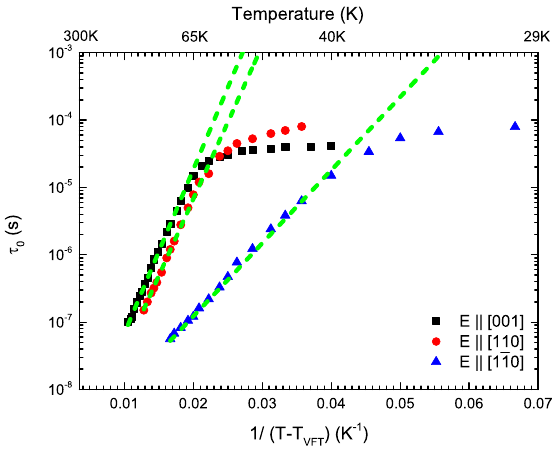
Figure 6. Arrhenius presentation of the mean relaxation time τ 0 ( T ) of λ -(BEDT-STF) 2 GaCl 4 mea- sured along the [ 001 ] (black square), [ 110 ] (red circle), and [ 1¯10 ] (blue triangle) axes. The solid green line corresponds to fits by the Vogel–Fulcher–Tammann expression (3).